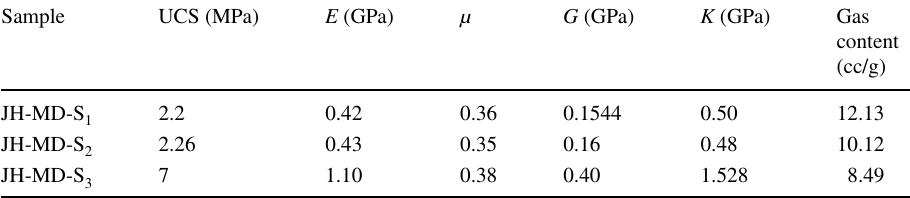
Fig. 6 Coal rank chart (Averitt and Berryhill 1950)